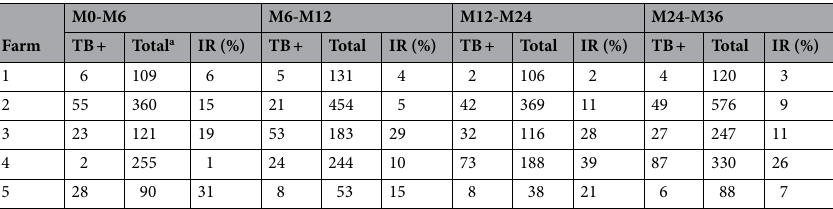
Table 2. Evolution of TB incidence risk (IR) in BCG vaccinated goats from farms throughout the study. a Total of susceptible animals was calculated by the addition of the new vaccinated goat kids minus the half of the number of vaccinated animals that died or were slaughtered between sampling time points (we assumed that they were present a half of the period).